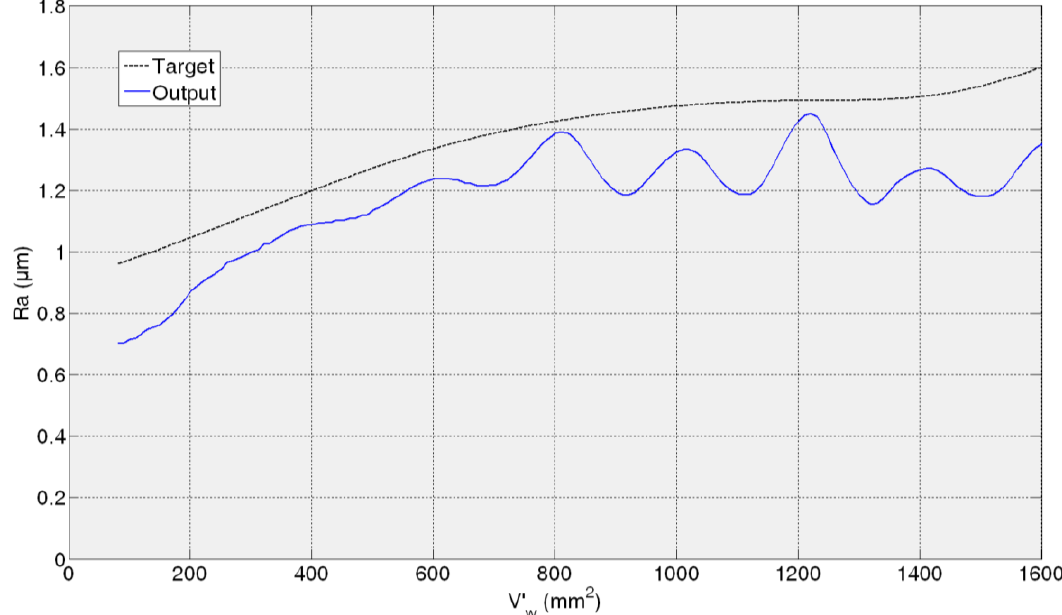
Figure 14. R measurement for 82AA36G6VW wheel, q a process